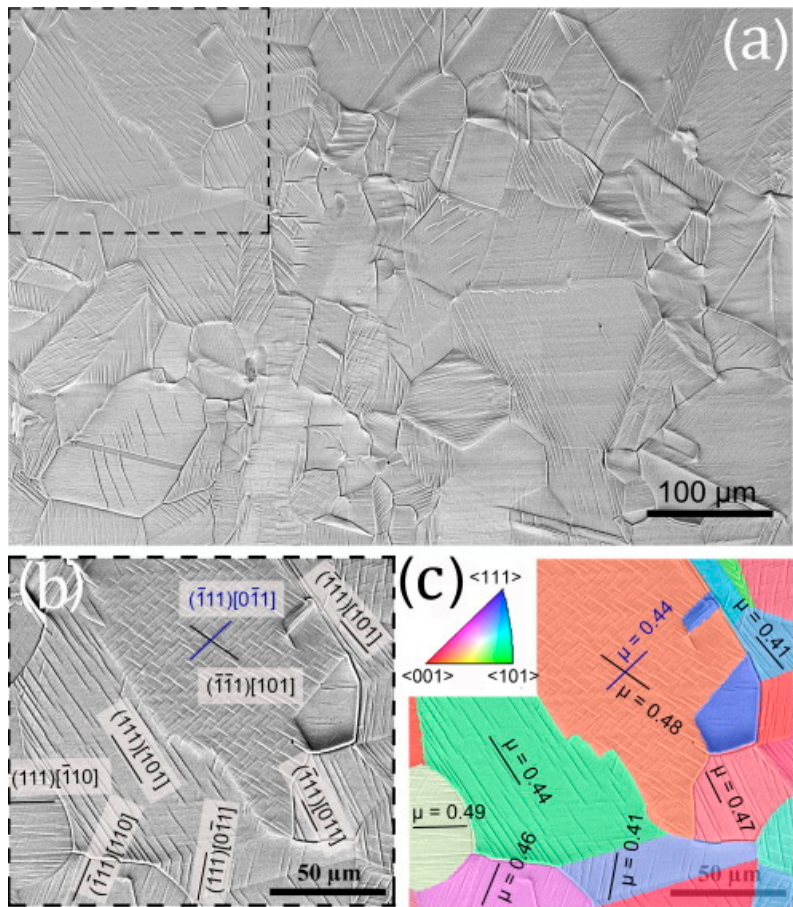
Figure 2. Surface morphology of an AISI 316L sample plasma nitrided at 400 °C, 3 h: ( a ) Scanning electron microscopy (SEM) image; ( b ) detail with the activated slip systems; ( c ) electron backscatter diffraction (EBSD) mapping of the image ( b ) with the calculated Schmid factor. For further details, see [120]. (Reprinted from Acta Materialia, 83, J.C. Stinville, J. Cormier, C. Templier, P. Villechaise, Modeling of the lattice rotations induced by plasma nitriding of 316L polycrystalline stainless steel, 10–16, Copyright (2015), with permission from Elsevier).